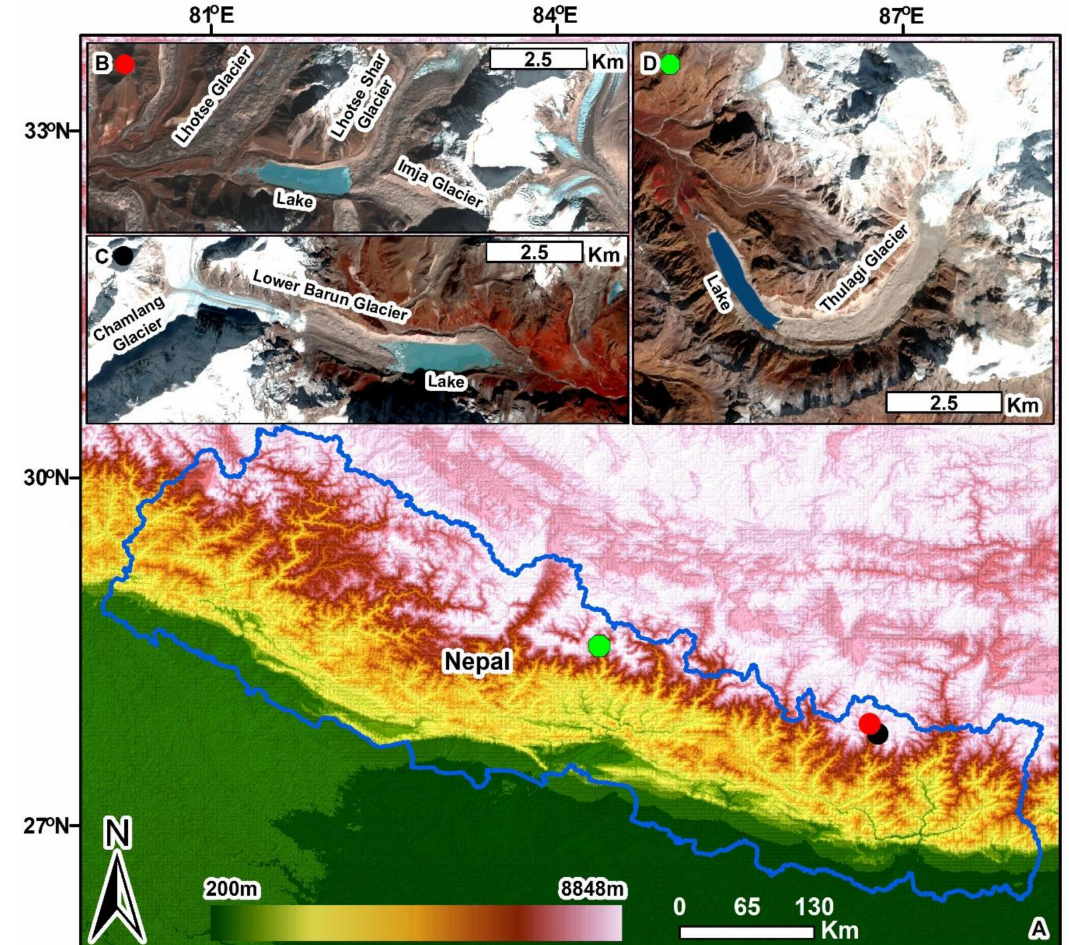
Figure 1. Map of our study area. ( A ) GTOPO30 topographic hillshade showing Nepal and the surrounding region. Three studied lake locations are marked—Imja (red dot), Lower Barun (black dot), and Thulagi (green dot); Sentinel 2 satellite images (false color infrared bands 8, 4, 3) in insets ( B ) and ( C ) (19 November 2016), and ( D ) (22 November 2016) showing Imja, Lower Barun, and Thulagi Glacier and Lakes along with their tributaries and the nearby